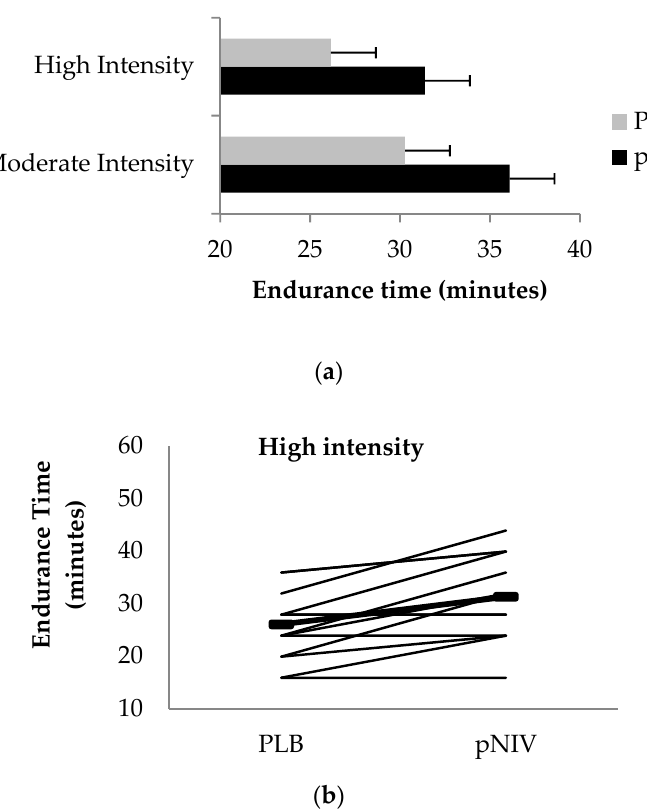
Figure 3. Exercise endurance time using pNIV (solid bars) and PLB (grey bars) during high- and moderate-intensity exercise protocols ( a ). E ff ect of pNIV on individual patient exercise endurance time during high-intensity ( b ) and moderate-intensity ( c ) exercise protocols. Solid lines indicate mean